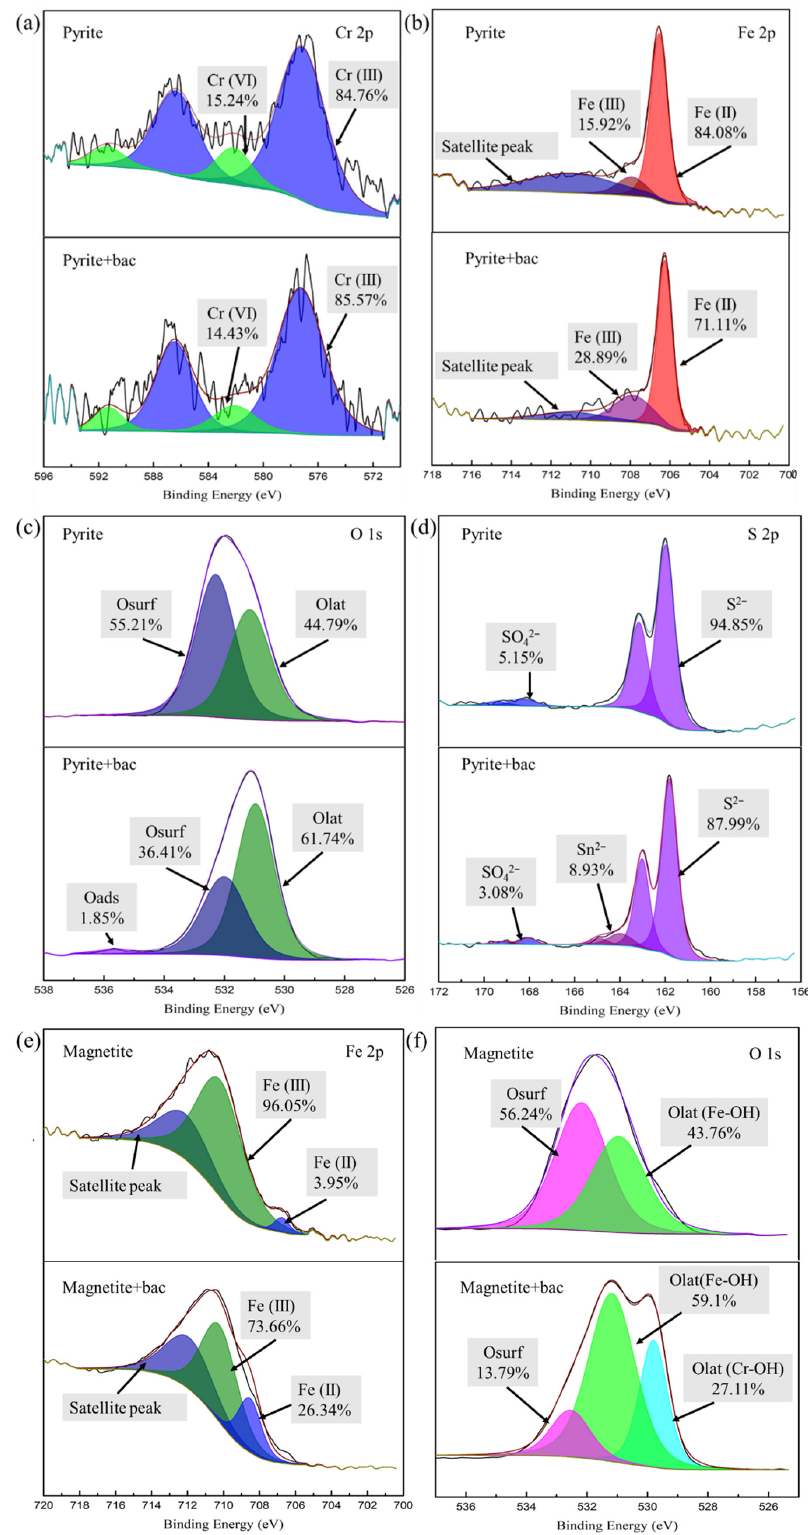
Figure 3. XPS key elements of Cr, Fe, O, and S in different Cr (VI) reduction systems: ( a ) XPS spectra of Cr 2p in pyrite system. ( b ) XPS spectra of Fe 2p in pyrite system. ( c ) XPS spectra of O 1s in pyrite system. ( d ) XPS spectra of S 2p in pyrite system. ( e ) XPS spectra of Fe 2p in magnetite system. ( f ) XPS spectra of O 1s in magnetite system.